Question: What form of chart is displayed?
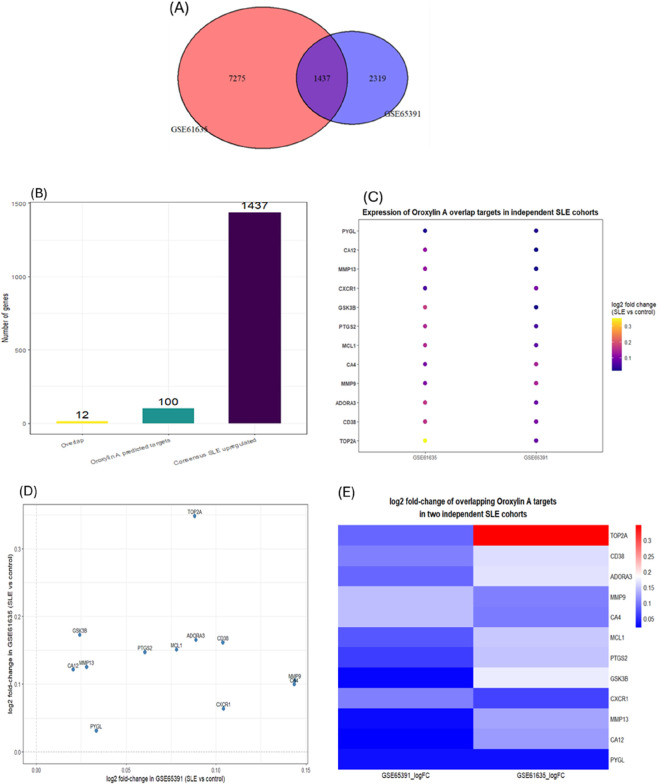
Answer: heatmap